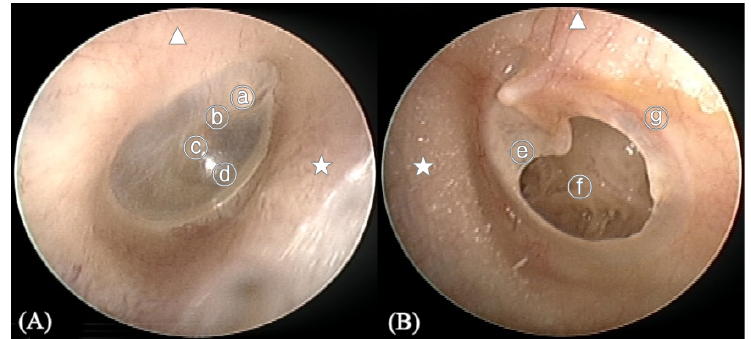
Figure 2. Anatomy of the tympanic membrane (TM). ( A ) Right normal TM ( B ) Left TM with perforation. ⓐ Malleus short process, ⓑ Handle of malleus, ⓒ Umbo, ⓓ Cone of light, ⓔ Perforation margin, ⓕ Middle ear, ⓖ Annulus of TM, ★ Anterior of external auditory canal, ▲ Superior of external auditory canal.